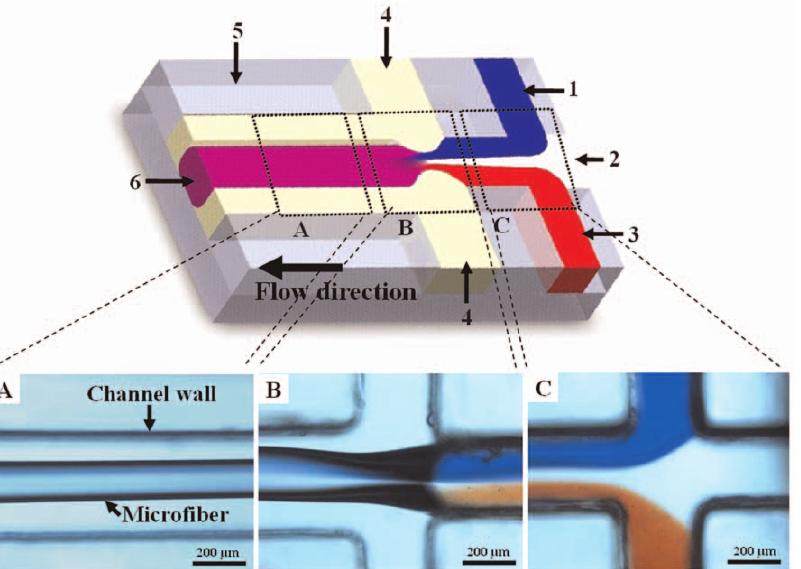
Figure 2. Microfiber formation. The diagram of the microfluidic system and photographs of observation positions. 1, 2 wt % CaCl 2 solution; 2, deionized water; 3, alginate solution; 4, sunflower seed oil; 5, observation channel; 6, microfibers. The formation of microfibers: A, photograph of the microfiber in the observation channel; B, Photograph of the second cross junction; C, photograph of the first cross junction.